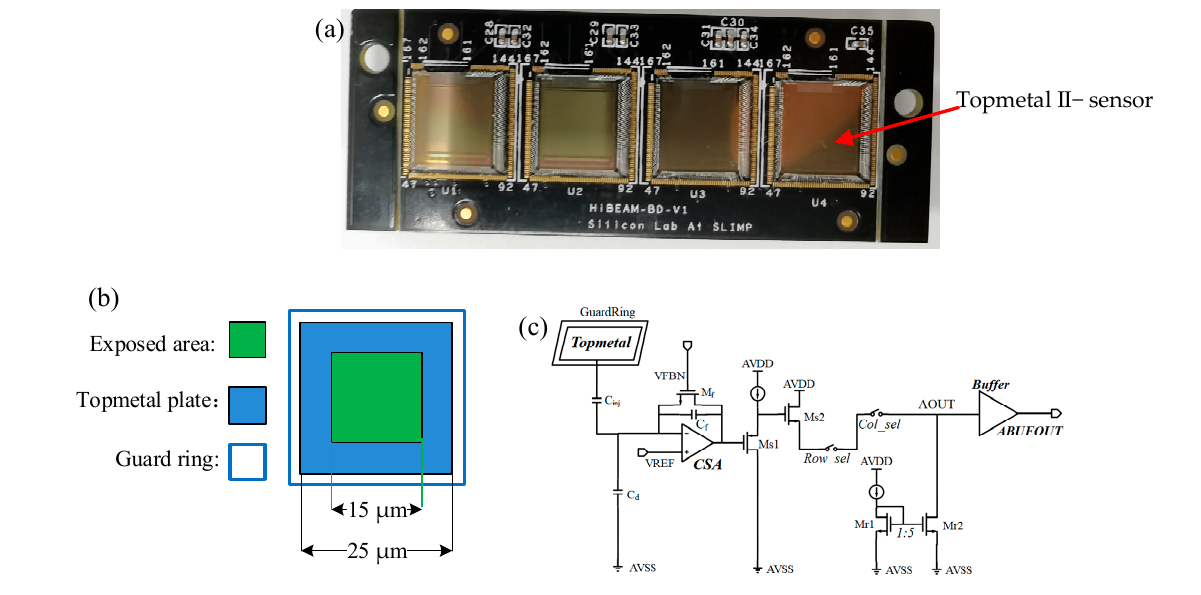
Figure 4. ( a ) Picture of the FEM. ( b ) The Topmetal plate’s structure of each pixel. ( c ) Signal path in the Topmetal II − .